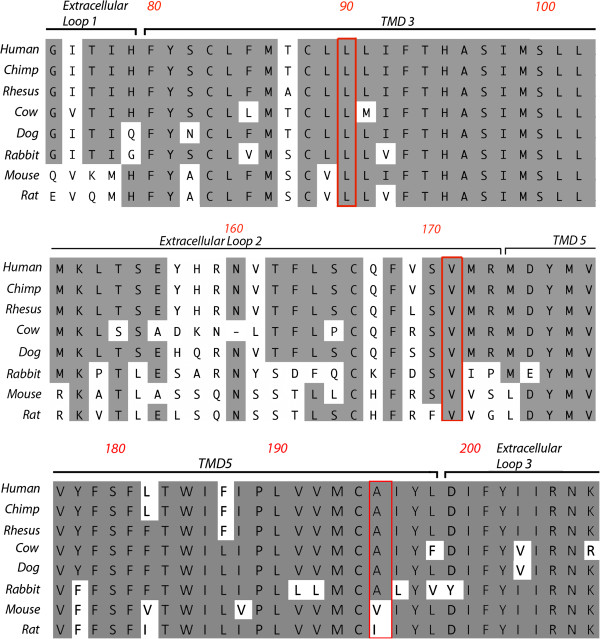
Cross-species conservation at ADORA3 variant sites detected by Sanger sequencing. Amino acid sequences of the A3AR protein encoded by ADORA3 are aligned for the three variants and their flanking residues: Leu90Val, Val171Ile (cases), and Ala195Thr (controls).